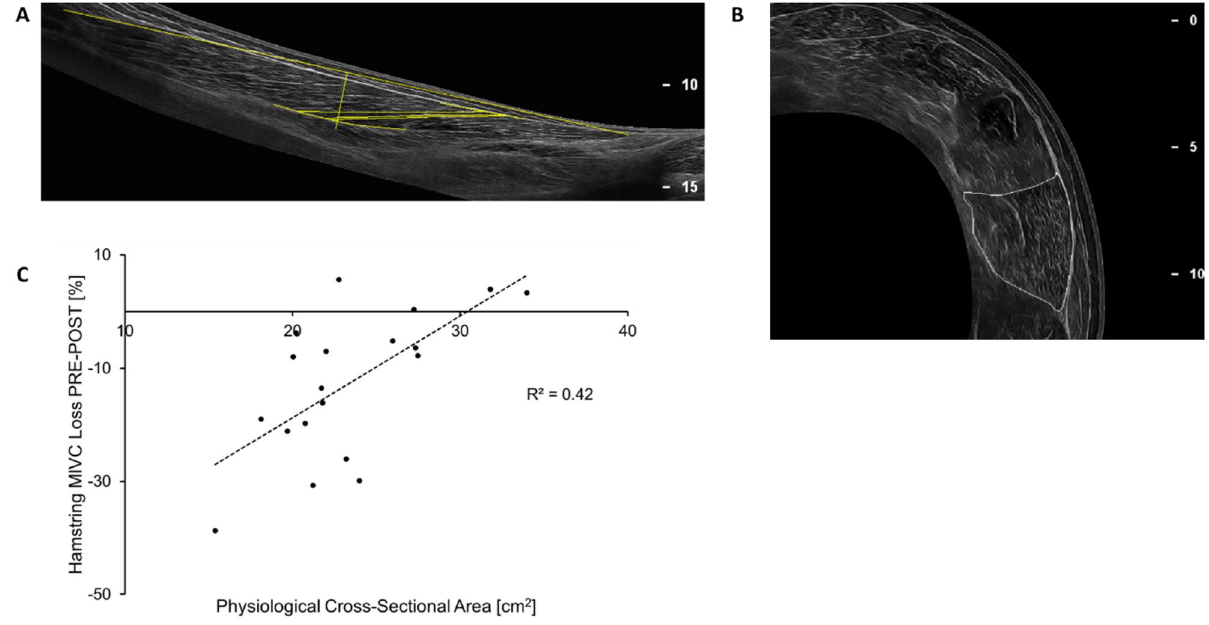
Figure 3. ( A ) Longitudinal image of biceps femoris long head, assessment of the biceps femoris long head is highlighted (total muscle length and fascicle length together with pennation angle at 50% of total muscle length). ( B ) Cross-sectional image at 60% muscle length (= 100% proximal myotendinous junction), biceps femoris long head is highlighted. ( C ) Correlation between biceps femoris long head muscle physiological cross- sectional area and % hamstring maximum isometric voluntary contraction (MIVC) decrease from before (PRE) to immediately after (POST) the repeated maximal sprint intervention (P = 0.003). This figure ( C ) was produced in Microsoft Excel